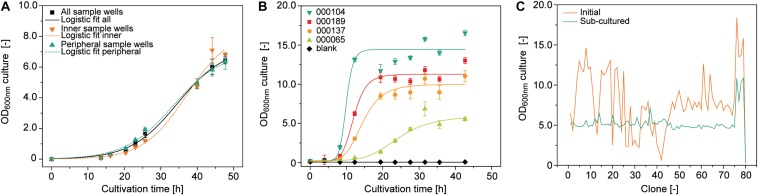
Growth of A. tumefaciens cultivated in a 96-well deep plates on the robotic platform. (A) Logistic fit (Equation 1) (adj. R2 = 0.996) to growth data from 92 (all sample wells, adj. R2 = 0.984), 6 (inner sample wells, adj. R2 = 0.994) or 32 replicates (peripheral sample wells) of A. tumefaciens clone 000101 inoculated with an OD600nm of 0.01 from a single culture. (B) Logistic fit to growth data of A. tumefaciens 000104 (adj. R2 = 0.97), 000189 (adj. R2 = 0.98), 000137 (adj. R2 = 0.98), 000065 (adj. R2 = 0.97) (n ≥ 23) automatically and individually inoculated with a starting OD600nm of 0.1 from pre-cultures with starting OD600nm values of 3.7, 1.7, 2.1, and 4.5, respectively. (C) Optical densities of 79 individual A. tumefaciens clones carrying different vectors (Supplementary Table S1) after 48 h (orange) and after an additional 24 h following automated sub-culturing step (green). The culture volume per well was 500 μL in all cases, with shaking at 1000 rpm and 4 mm eccentricity.